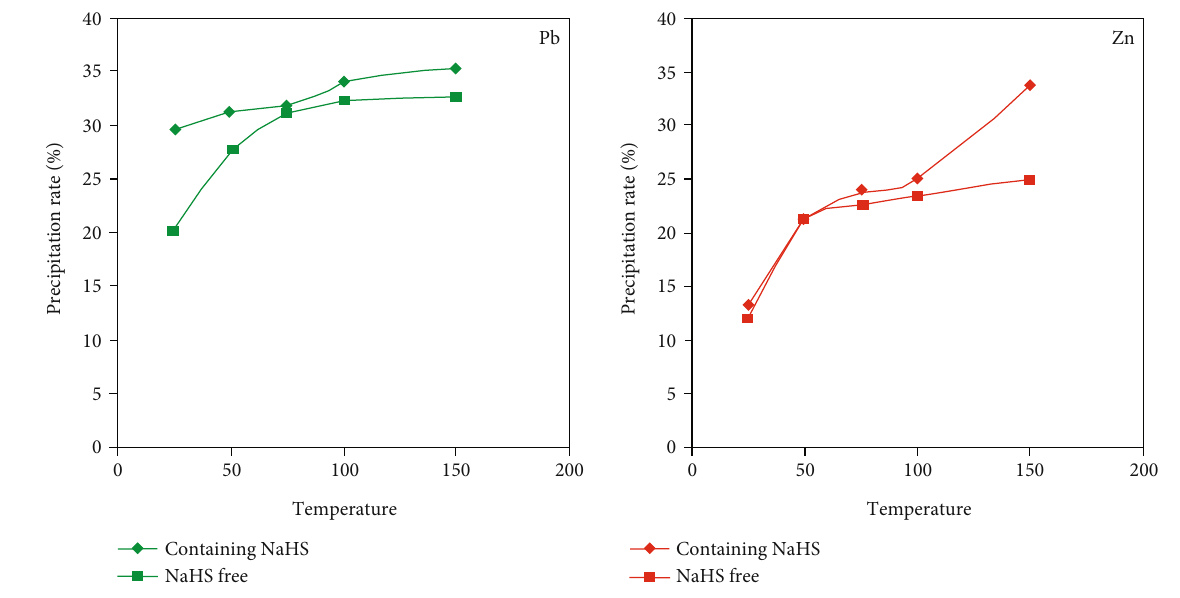
Figure 4: Temperature-precipitation rate diagram for the water-rock